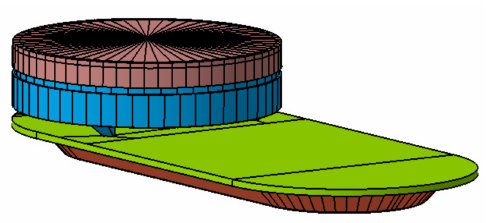
Figure 2. Modelling in 3D of the luminaire Model. Source: our own